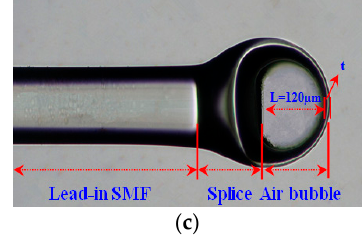
Figure 1. ( a ) Schematic diagram of sensor; ( b ) sensing mechanism; ( c ) photograph of micro-fiber cavity.